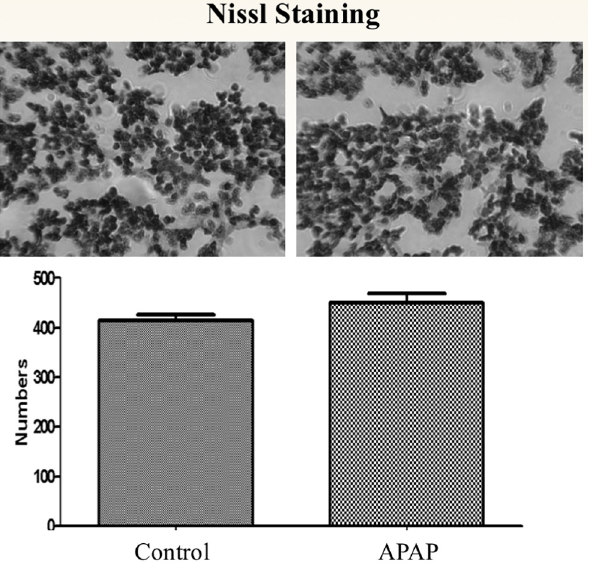
Fig 3. Cortical neuron densities in Nissl-stained frontal cortex of offspring between control and APAP groups. Whole brains were washed and processed for Nissl staining by immersing in 30% sucrose until saturation and cryosectioned at 20 μ m thickness. Neurons were counted (field of view) based on randomly chosen 5 fields in frontal cortex per animal. The neurons were identified by a large cell body or perikaryon containing a large, pale nucleus with a prominent dark nucleolus. Experiments were performed in 3 – 5 repeats for all groups. There was no significant difference in cortical neuron density between control and treated groups (p < 0.05; Unpaired Student ’ s T-Test; n = 5 control, n = 3 treated). Data are presented as the mean ± s. e.m. Statistical significance was determined using Student ’ s unpaired